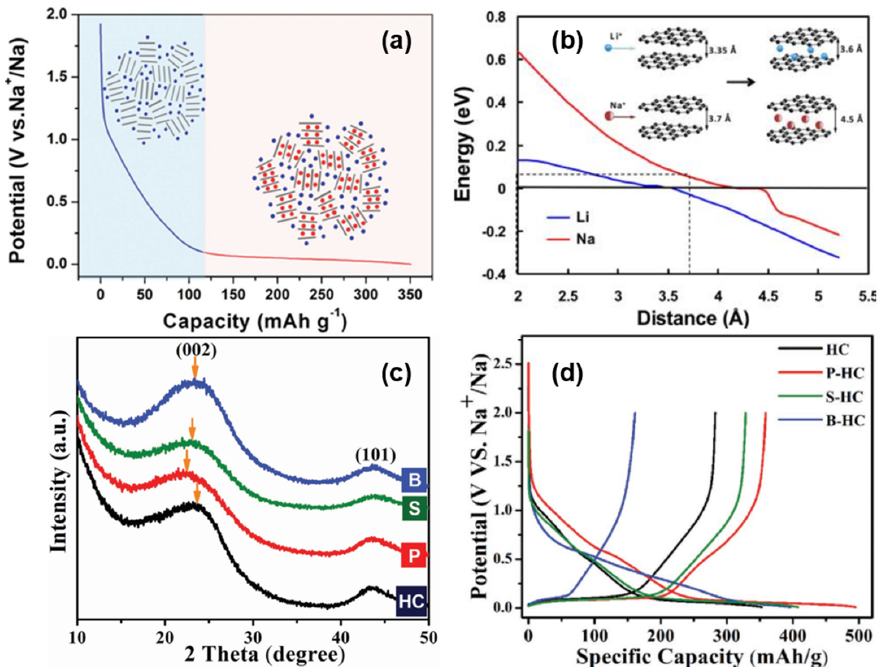
Figure 6. ( a ) Schematic illustration of the “adsorption-intercalation “ mechanism for Sodium-ion storage in HC [63]. ( b ) Theoretical energy cost for Na (red curve) and Li (blue curve) ion insertion into carbon as a function of the carbon interlayer distance. The inset illustrates the mechanism of Na and Li-ion insertion into carbon [64]. ( c ) XRD patterns of doped and original HCs. After P-doping and S-doping, the (002) peak shifts to a lower angle, which indicates a larger d-spacing. However, B-doping barely shifts the peak. ( d ) The galvanostatic sodiation and desodiation poten- tial profiles of the original HC and doped HCs at a current rate of 20 mA g −1 [65].